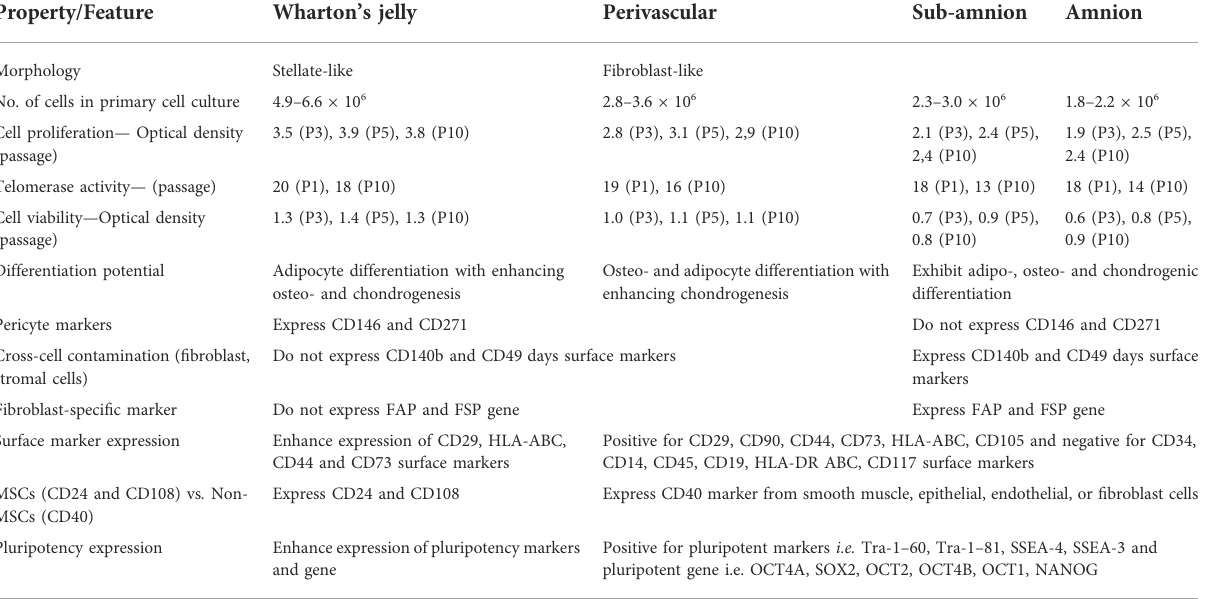
TABLE 1 Comparison of MSC characteristics isolated from the different sections of umbilical